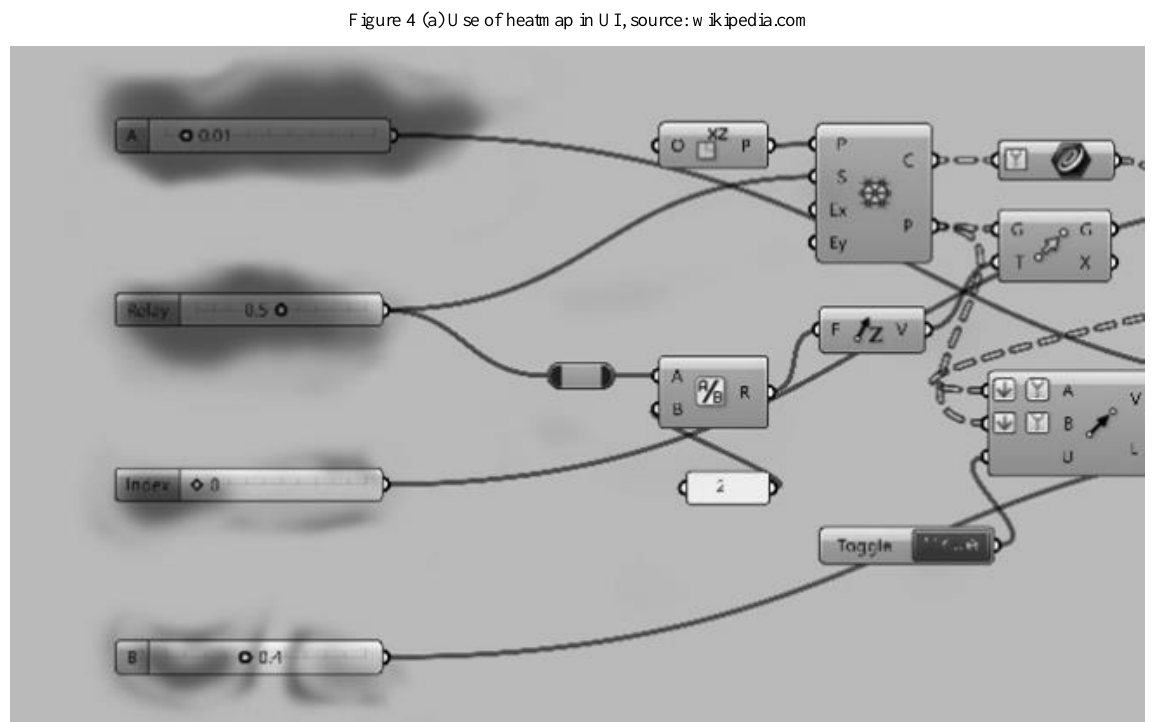
Figure 4 (b) Qualitative frequency of parameter